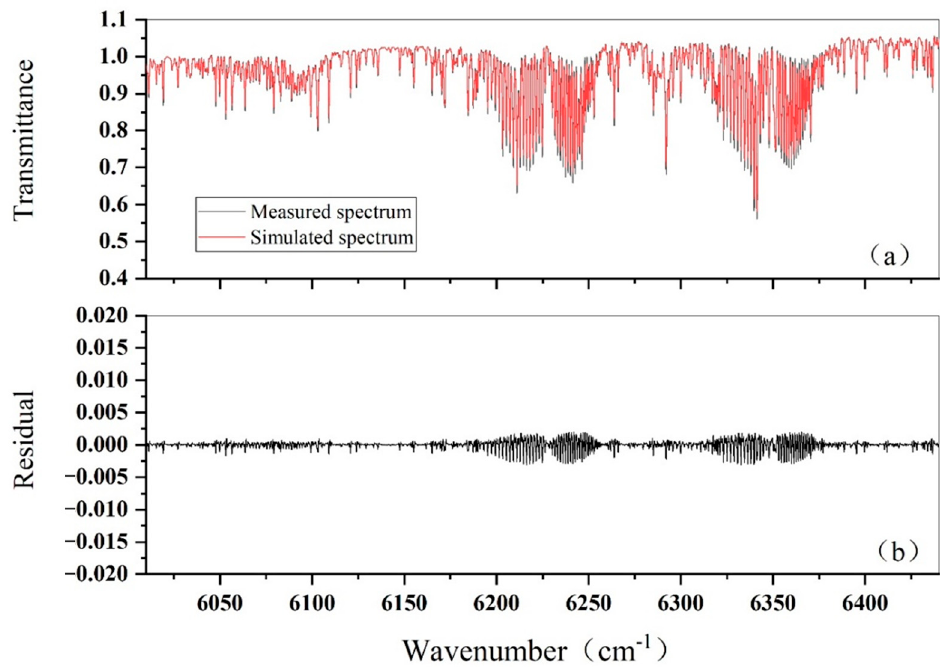
Figure 34. Measured spectra and corresponding simulated spectra of CO2 and CH4 channels ob- tained by HRFTS. (a: theoretical and measured spectra,b: difference between theoretical and meas- ured spectra).